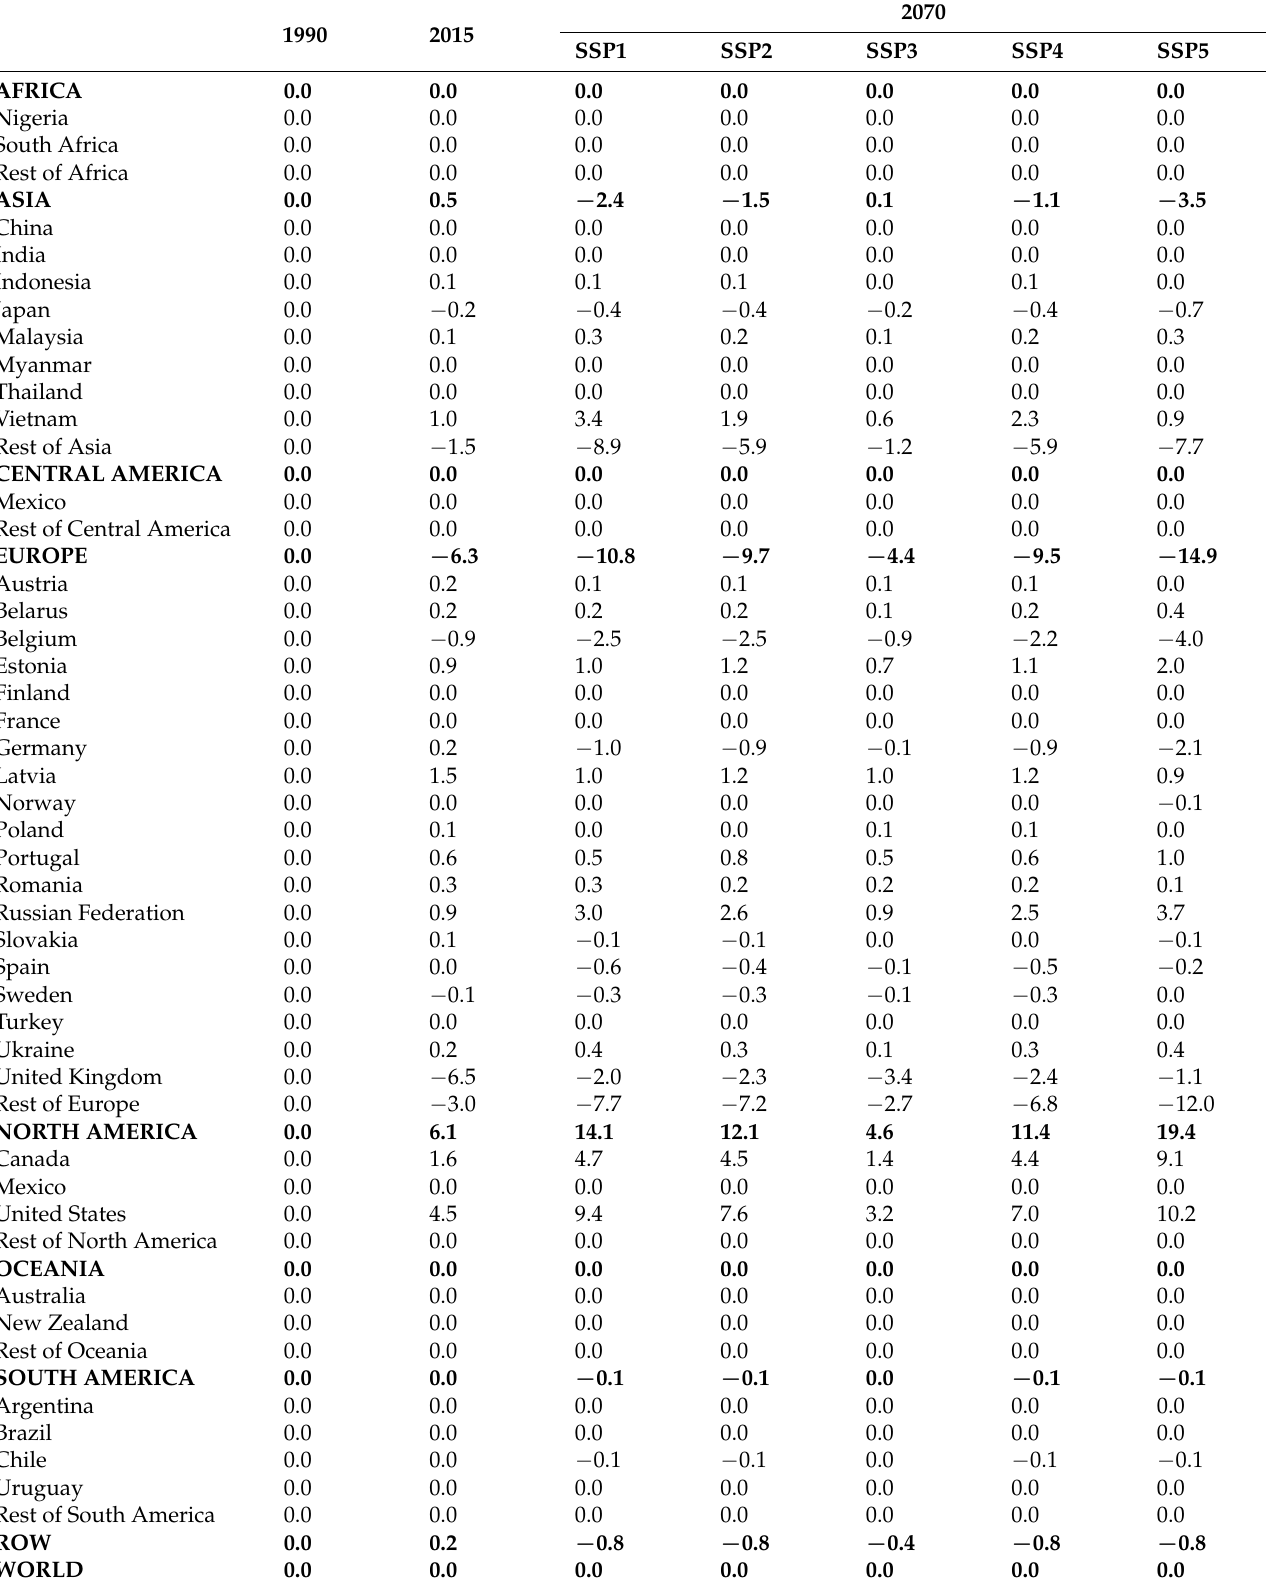
Table A6. Wood pellet net trade (million metric tons), 1990 to 2015 historic, 2070 projections from